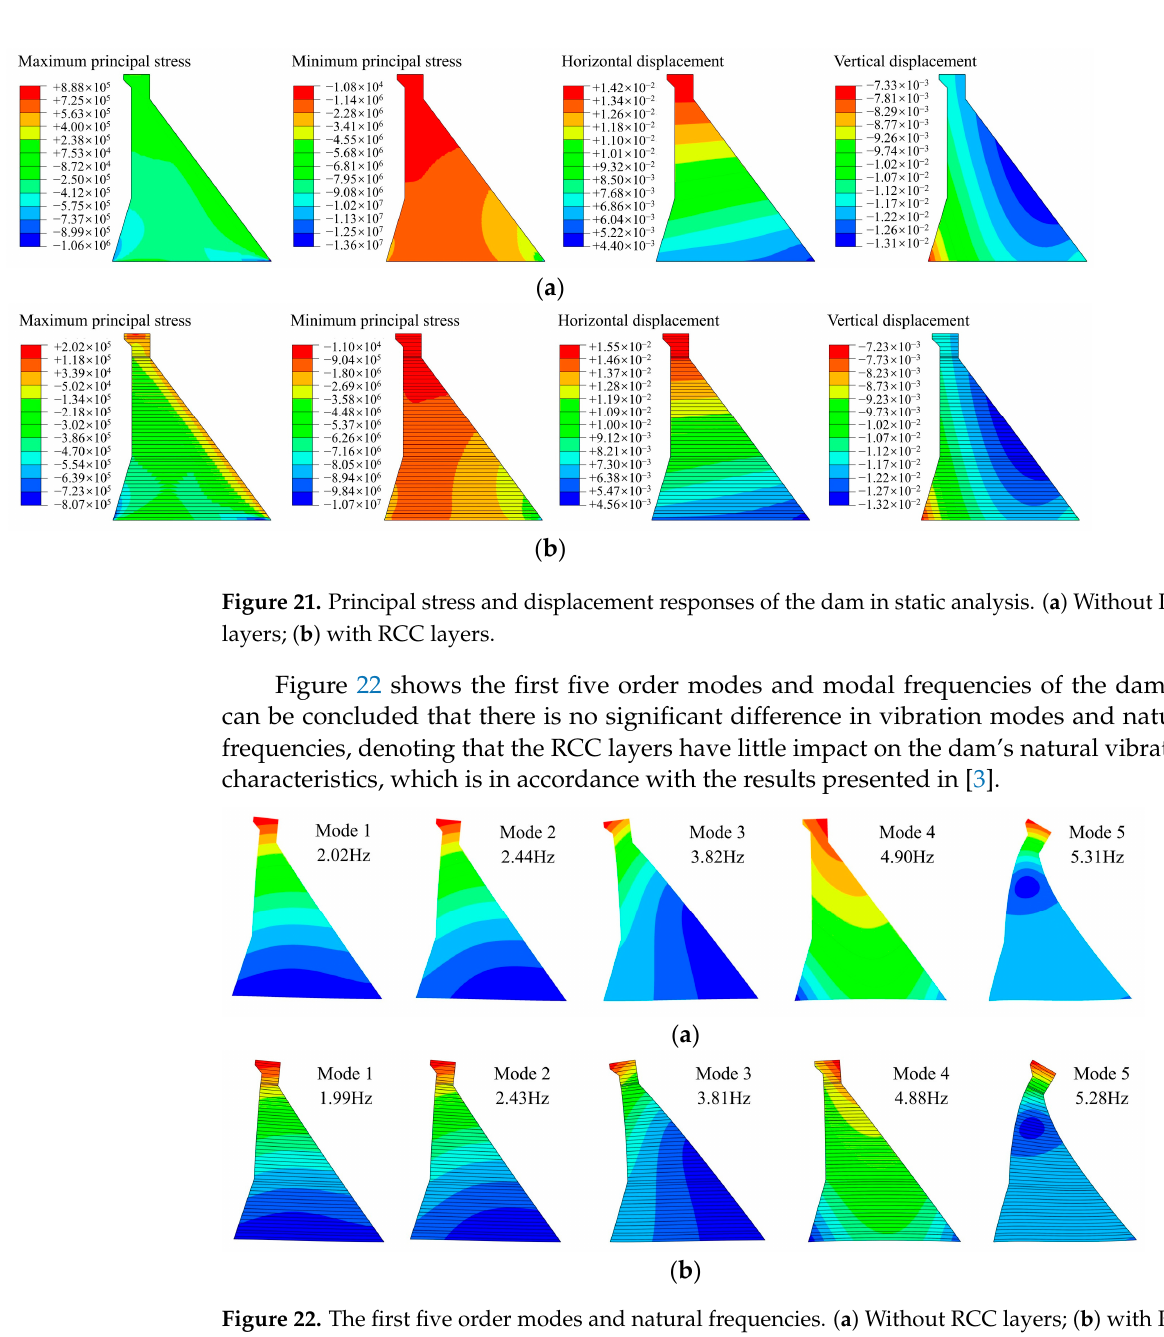
( b ) Figure 23. Displacement time histories of the dam crest. ( a ) Horizontal direction; ( b ) vertical direc- tion. The maximum and minimum principal stresses near the downstream slope change, with and without RCC layers, are depicted in Figure 24. The maximum tensile stresses of the two cases both exceed the tensile strength of the concrete. The maximum values of tensile and compressive stresses are reduced to a certain extent when RCC layers are pre- sent. When not considering RCC layers, the tensile stress of the selected element is not released after the failure occurs. On the contrary, the stress is almost released when RCC layers are present, and the residual stress is relatively small at the end of the earthquake duration. If the residual stress in the dam concrete is too large, the superposition of the residual tensile stress may cause the generation or expansion of cracks when the overall